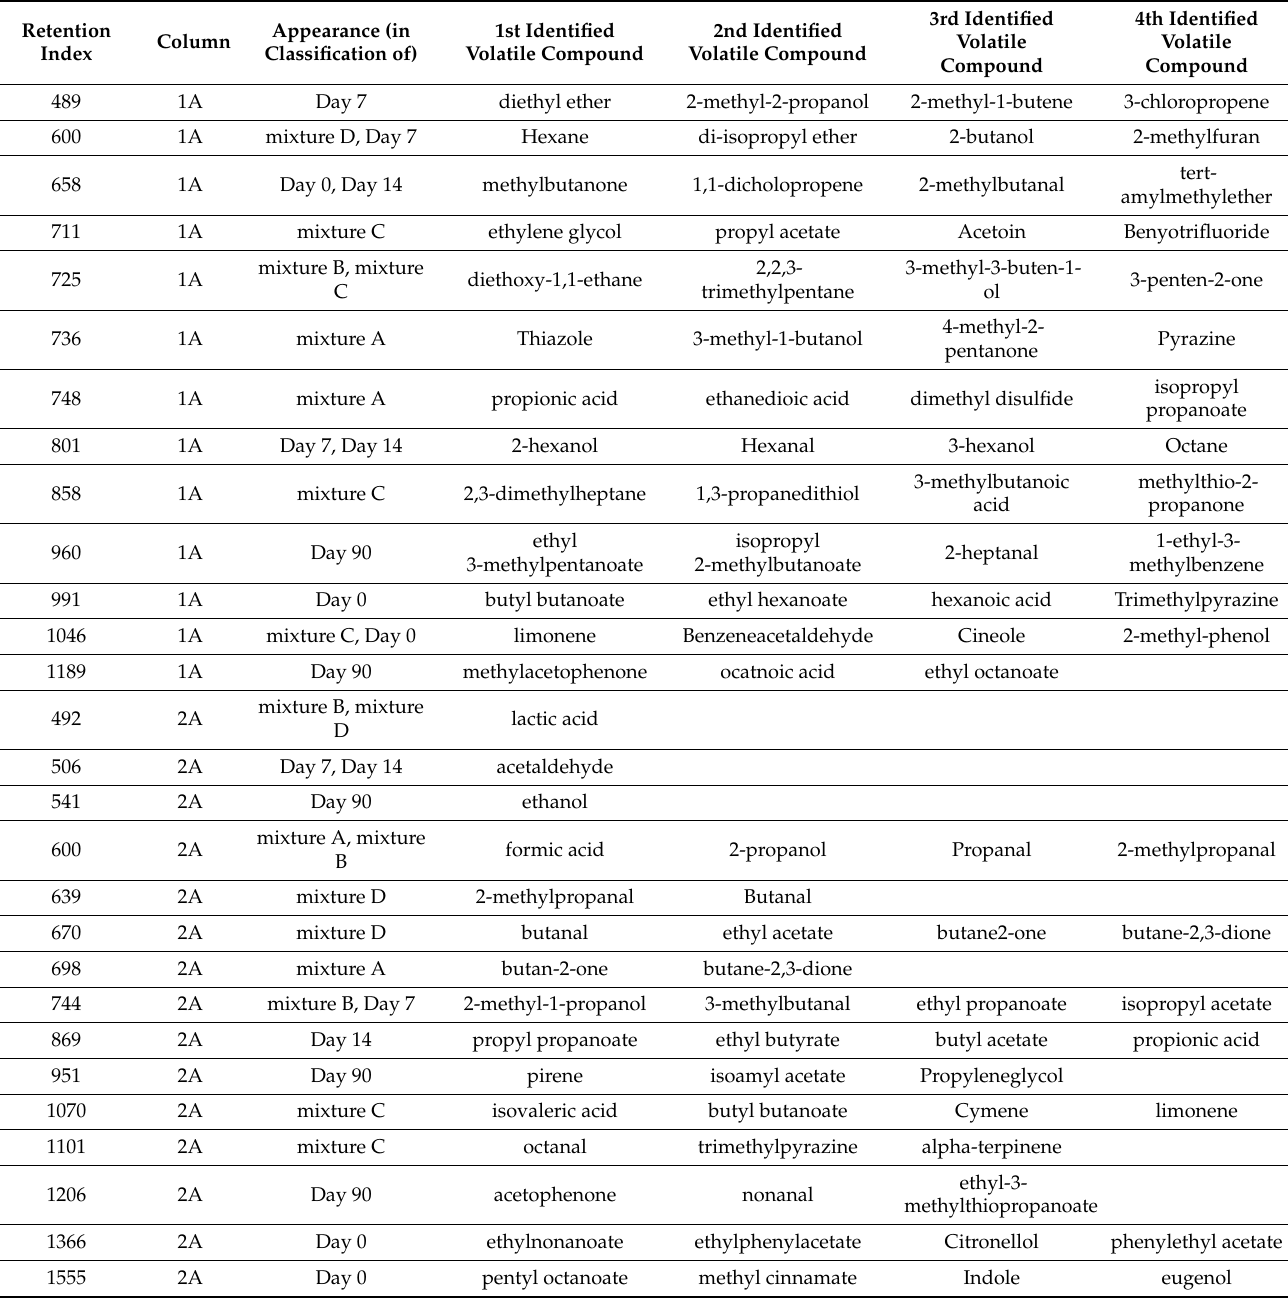
Table 5. Identification of the possible chemical components responsible for the signals at the retention indices appeared in the various classification